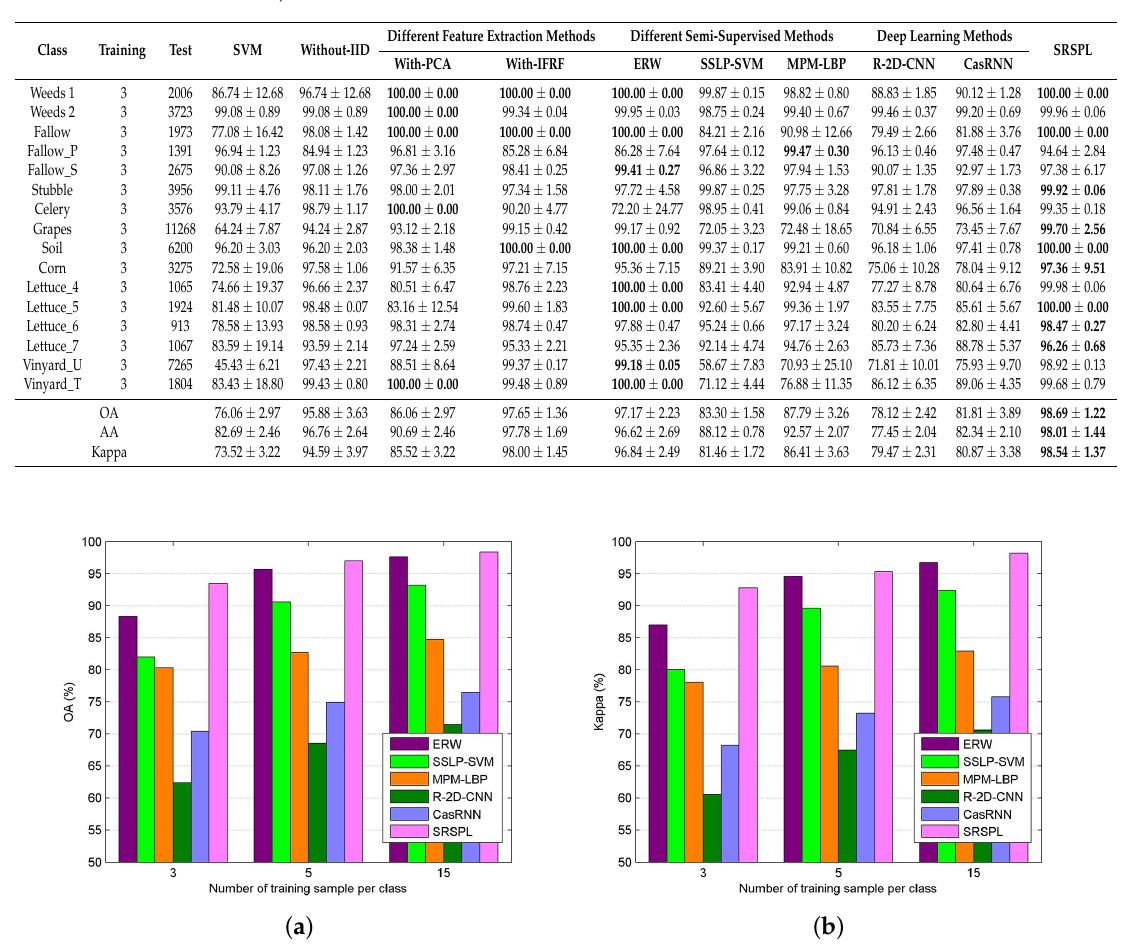
Table 3. Classification accuracies (University of Pavia) in percentages for the tested methods when 20 training samples per class are provided. (The bold values indicate the greatest accuracy among the methods in each case.)